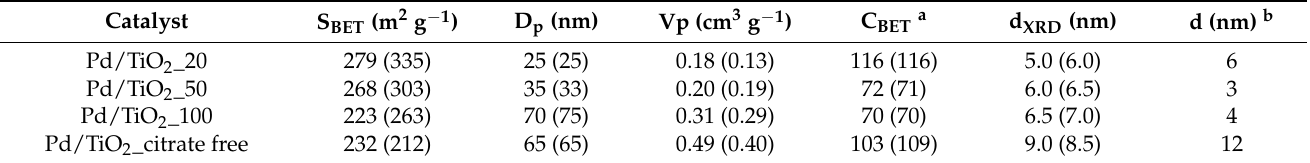
Figure 2. N2 adsorption–desorption isotherms and pore size distribution of Pd/TiO2_x (x = 20, 50 Figure 2. N 2 adsorption–desorption isotherms and pore size distribution of Pd/TiO 2 _x (x = 20, 50 and 100) and Pd/TiO2_citrate free catalysts. and 100) and Pd/TiO 2 _citrate free catalysts. Table 2. Surface areas and nanoparticles size for the Pd/TiO 2 _x (x = 20, 50, 100) and Pd/TiO 2 _citrate free catalysts.